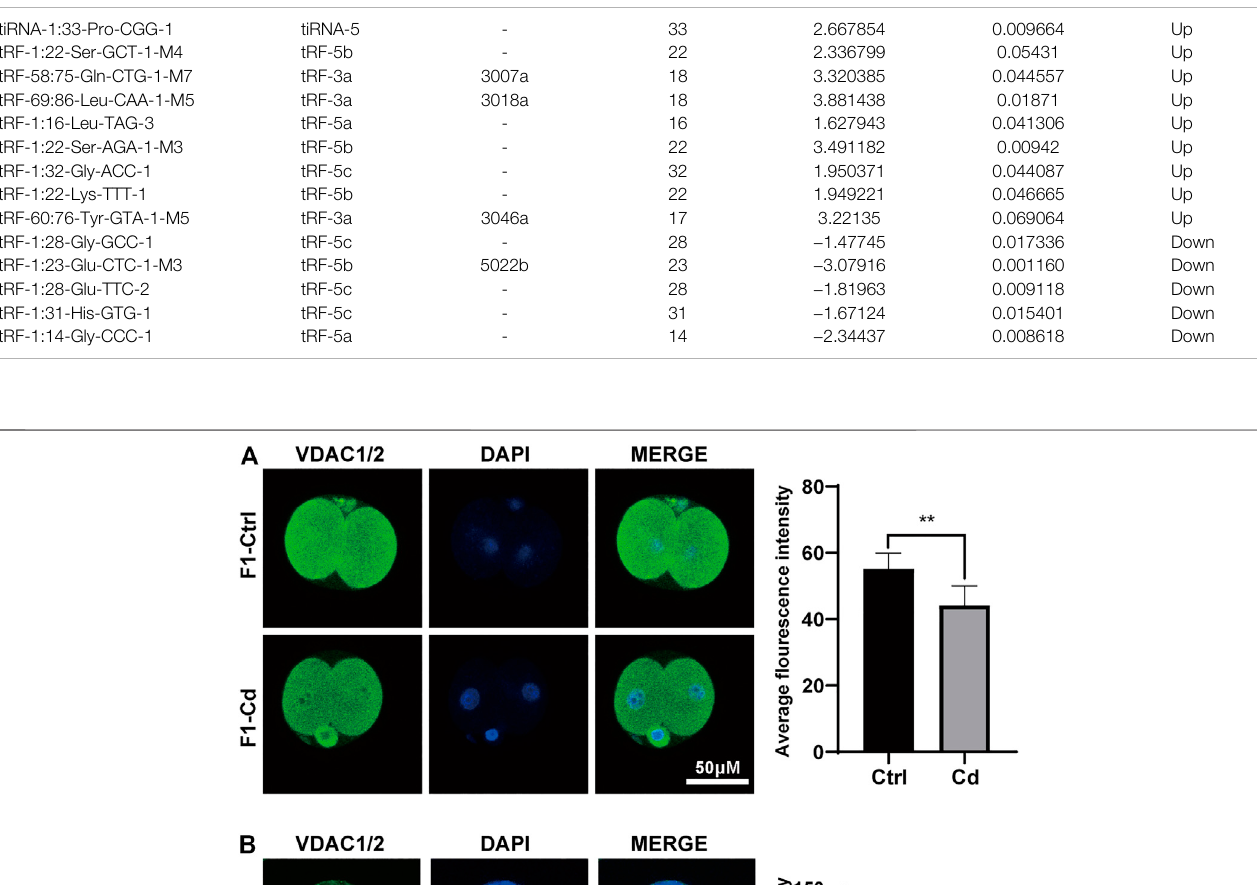
Frontiers in Cell and Developmental Biology |